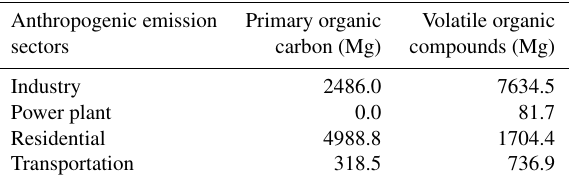
Table 2. Primary organic carbon and volatile organic compounds emissions from anthropogenic sources in Xi’an and surrounding ar- eas (the area surrounded by the white line in Fig. 1c) in